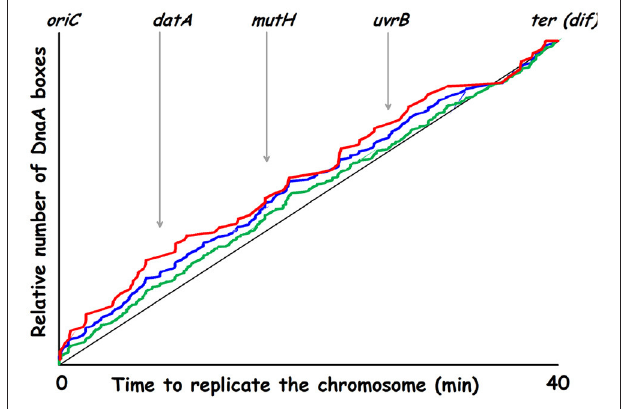
FIGURE 10 | Replication time for DnaA boxes on the K-12 chromosome. Green curve: 307 consensus DnaA boxes (TTWTNCACA); blue curve: 164 DnaA boxes (TTATNCACA + TTTTCCACA); red curve: 78 DnaA boxes (TTATNCACA where N is either C, A, or G). Genes in or lying close to chromosomal regions involved in nucleotide conversions are